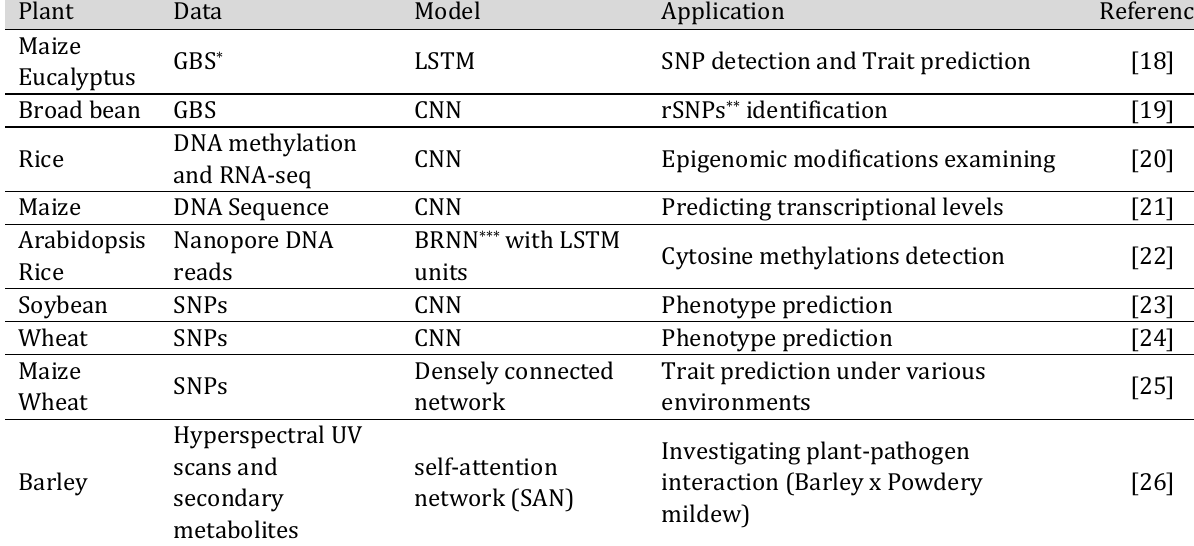
Table 1. Recent deep learning applications in plant